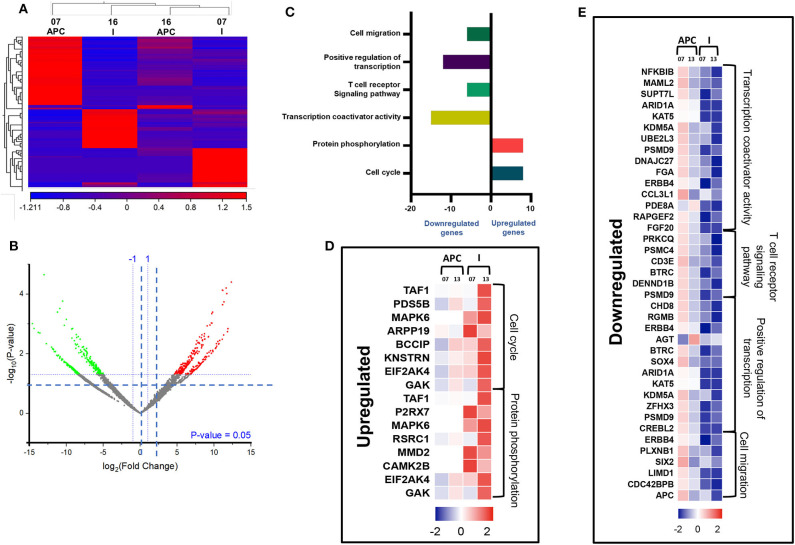
Comparative analyses of gene expression between I-MDSCs and monocytic APCs in the circulation of CRC patients. Hierarchical clustering of I-MDSCs and monocytic APCs from two patients (07 and 16) on differentially expressed transcripts. Expression level of each gene is illustrated as a color code (A). Volcano plot illustrates the differential expression data, represented as log2 fold change on the x-axis, with the statistical impact on the y-axis. Fold changes with significant P values (>0.05) are highlighted in red (for upregulated genes) and green (for downregulated genes) (B). Functional categorizations for significantly upregulated and downregulated transcripts were analyzed on DAVID platform. Bar diagram illustrates the percentage of genes in each functional category (C). Heat maps show Z score of the upregulated (D) and downregulated (E) transcripts in I-MDSCs, compared with monocytic APCs, based on their functional categorization.